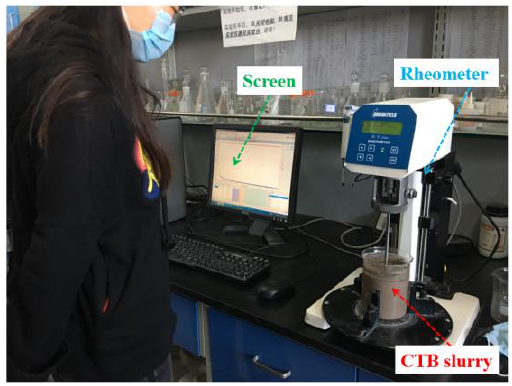
Figure 3. Rheology testing apparatus of the CTB slurry mixes.